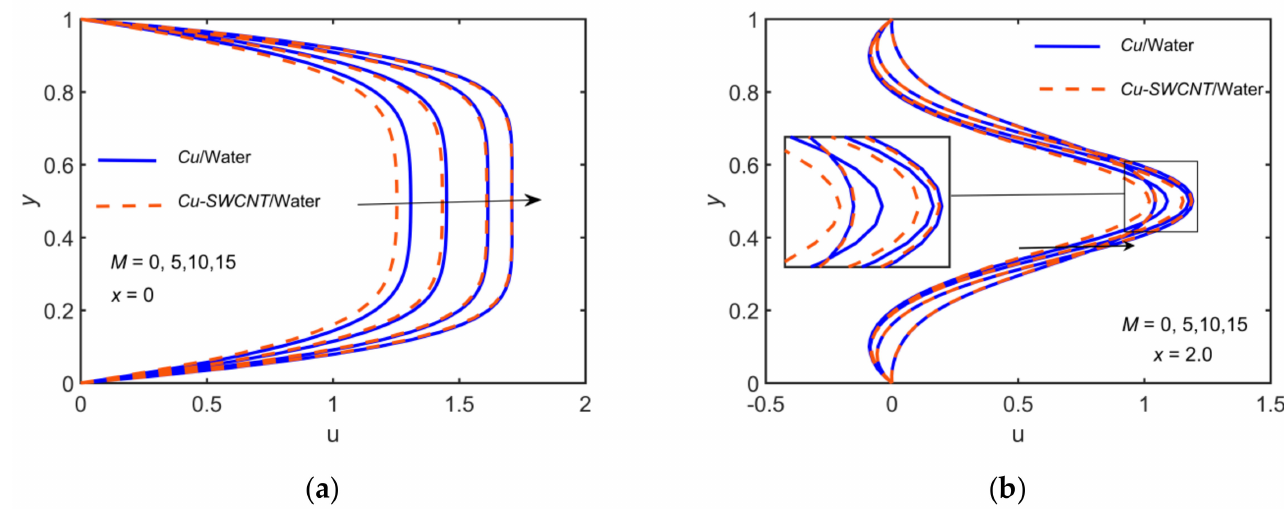
Figure 8. Comparison of Cu /water and Cu – SWCNT /water for the velocity profiles for M = 0, 5, 10, and 15 with St = 0.02, Pr = 1, Rd = 0.2, Re = 700, φ = 0.02, and t = 0.25 at ( a ) x = 0 ( b ) x =